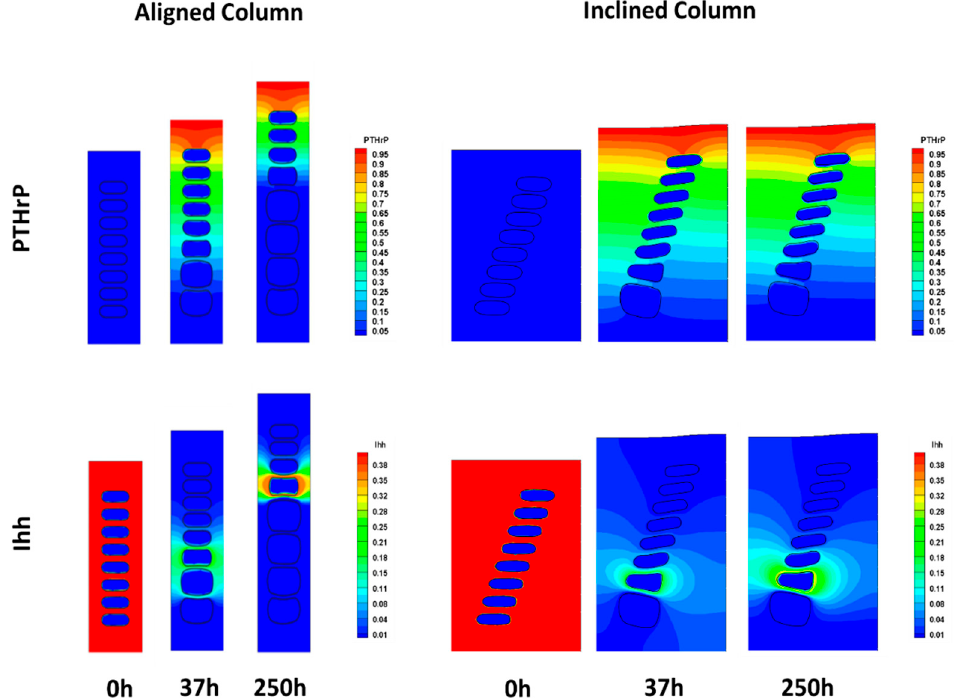
Figure 9. Indian hedgehog protein (Ihh) and parathyroid hormone-related protein (PTHrP) concentration changes over time for a normal and an inclined growth plate column. Images show the diffusion patterns observed for PTHrP (upper panel) and Ihh (lower panel) at times 0, 37, and 250 h of simulation using the mechanobiological model described in [26]. Results correspond to the simulations performed using morphologies corresponding to a growth plate column aligned with the longitudinal bone growth axis ( left ) and an inclined column ( right ).